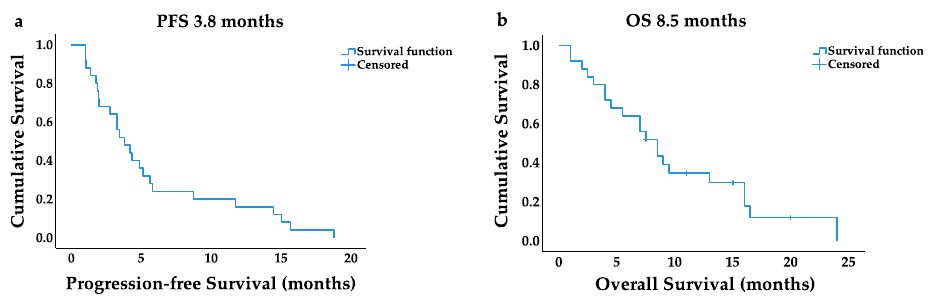
Figure 2. Kaplan–Meier survival curves. ( a ) Progression-free survival in months; ( b ) overall survival in months.